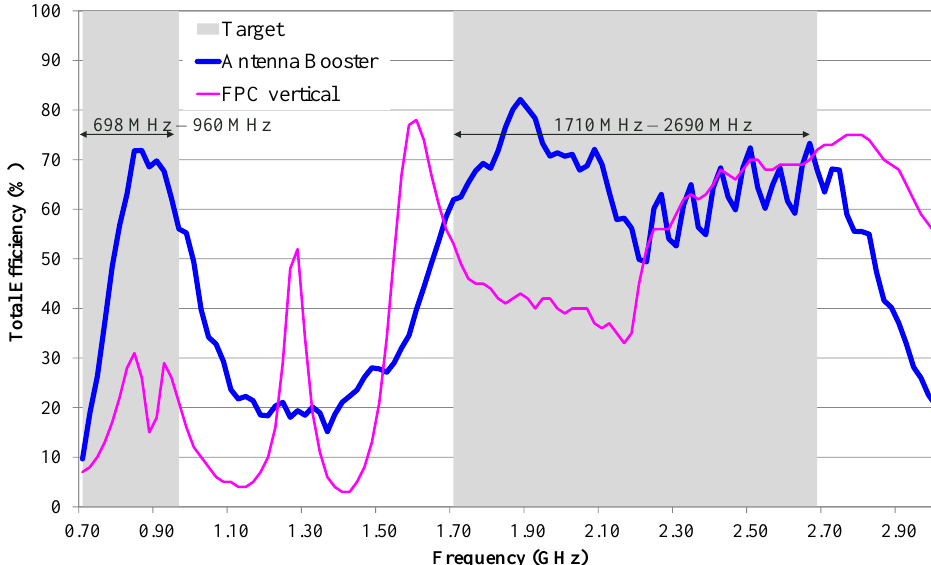
Figure 7. Measured total efficiency for the antenna booster and FPC solutions in Figure 6. Table 3. Measured total efficiency for the FPC and booster antenna .